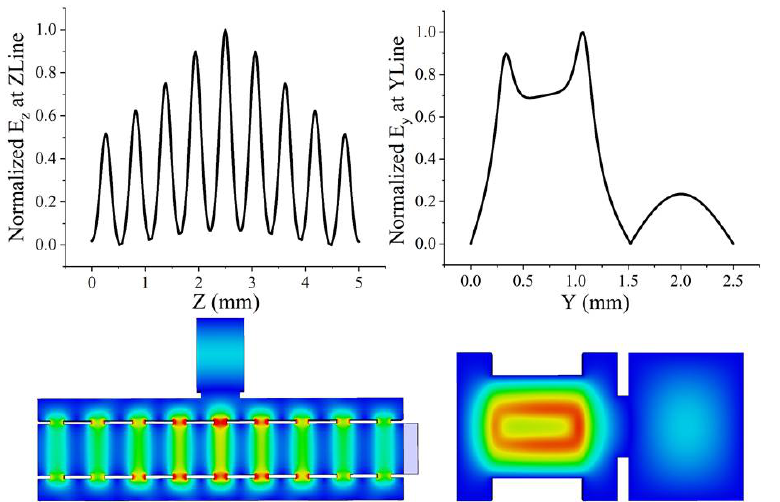
the mid-point of the top coupling cavity.